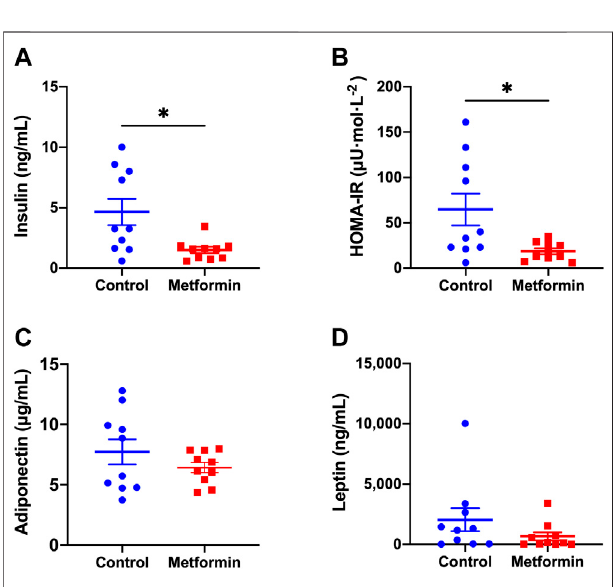
FIGURE 3 | Metabolic pro fi les of metformin and control groups after treatments. Data was presented as mean ± standard error of the mean. * denote that these values were signi fi cantly different between two groups; Figure 3A : p = 0.0117; Figure 3B : p =0.0179.HOMA-IR:Homeostatic Model Assessment for Insulin